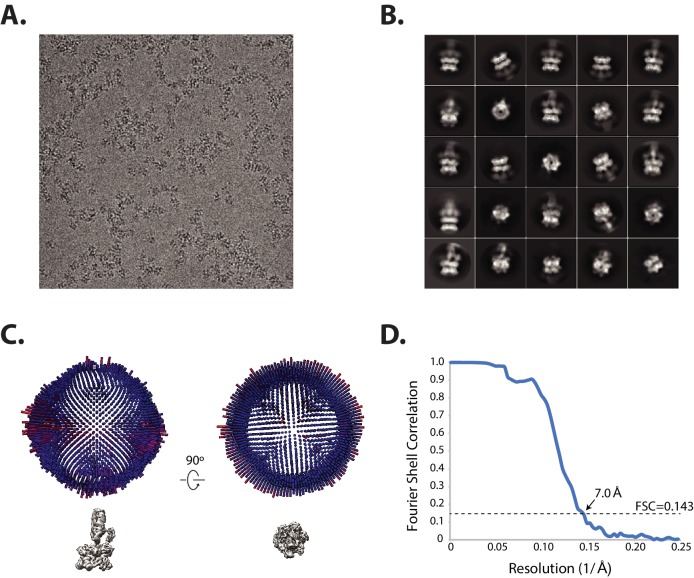
Single particle cryo-EM analysis.(A) Representative electron micrograph of the L-20S (NSF/αSNAP/L-SNARE) complex. (B) Selected 2D class averages. (C) Plots of the angular distribution of particle projections. The radius of the sphere at each projection direction is proportional to the number of particle images assigned to it. Two orthogonal views are shown. (D) FSC curve for the 3D density map after RELION post-processing. The resolution is estimated to be 7.0 Å by the FSC = 0.143 criterion.